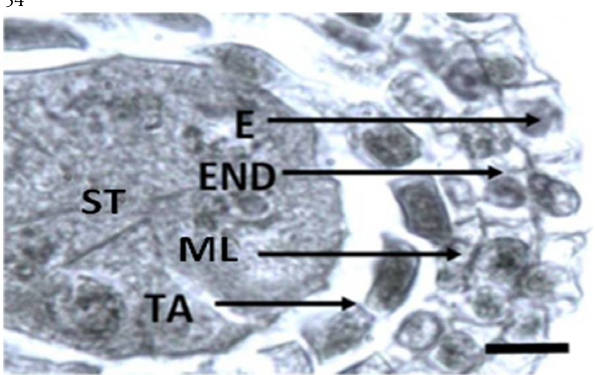
Fig. 3. Anther wall layers and sporogenous tissue of H. annuus L.; E: